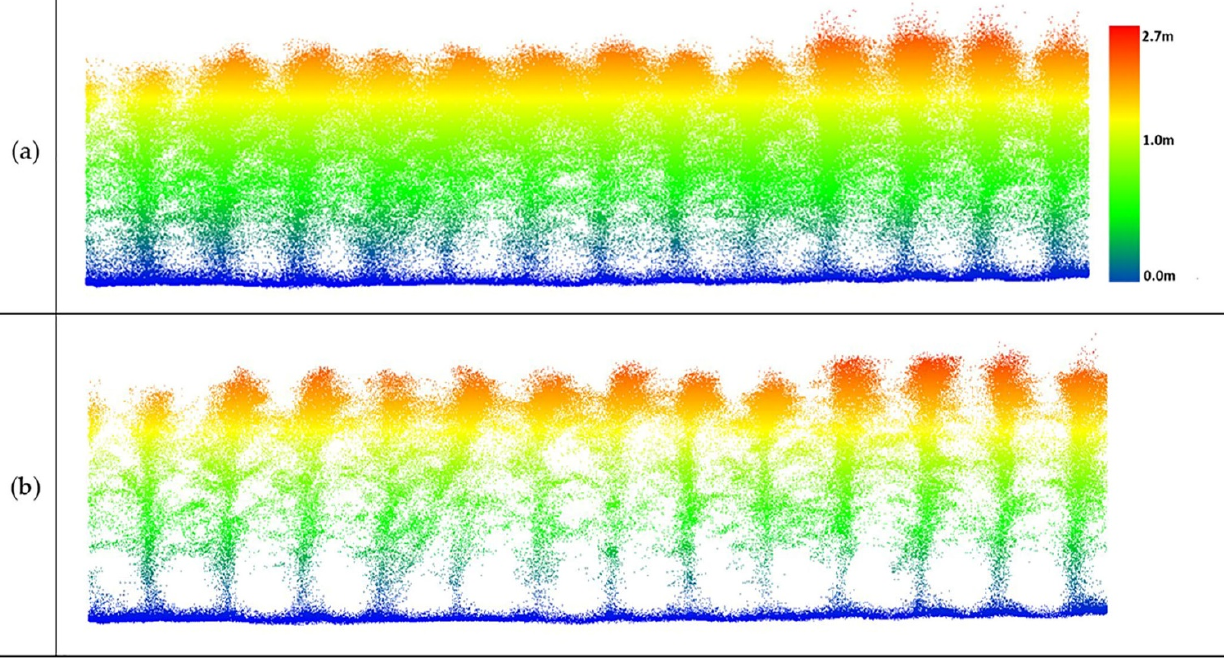
Figure 20. PhenoRover LiDAR data of maize (DAS:62). ( a ) Original data, ( b ) outlier removal using PointCleanNet. Figure 21 shows a sample of sorghum data collected by UAV-2 flown at the altitude of 20 m.